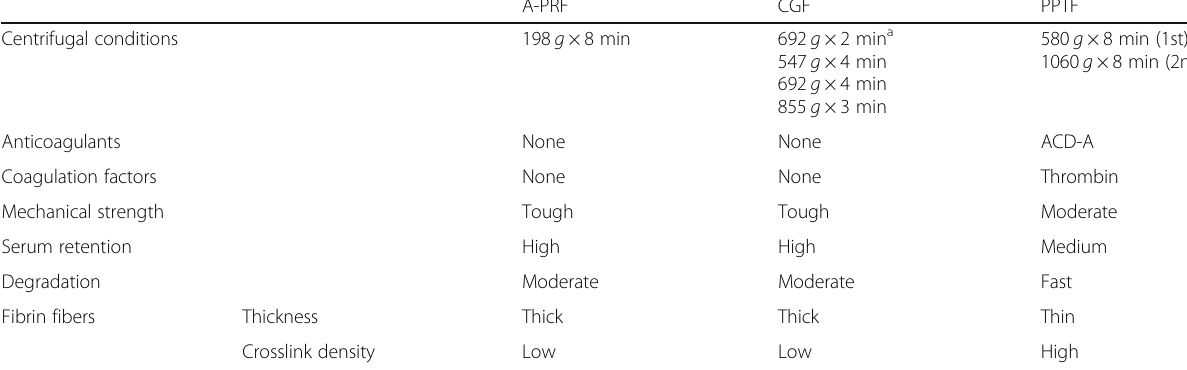
Table 3 Summaries of preparation procedures, relative mechanical, degradation, and related properties of A-PRF, CGF and